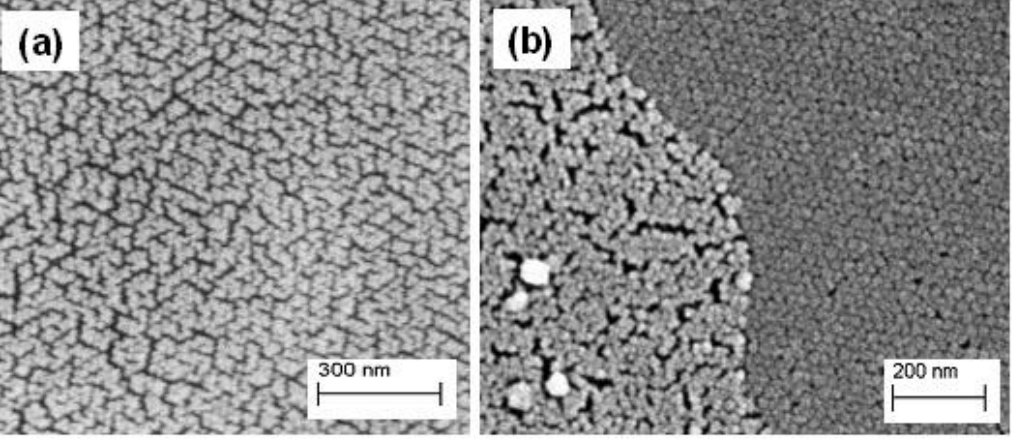
Figure 4. SEM images of a regular sphere surface and edge of fracture showing dense hexagonal close packing of the structure. A very thin surface layer shows marked porosity over the interior and may partially explain the observed green fluorescence intensity at the edges in Figure